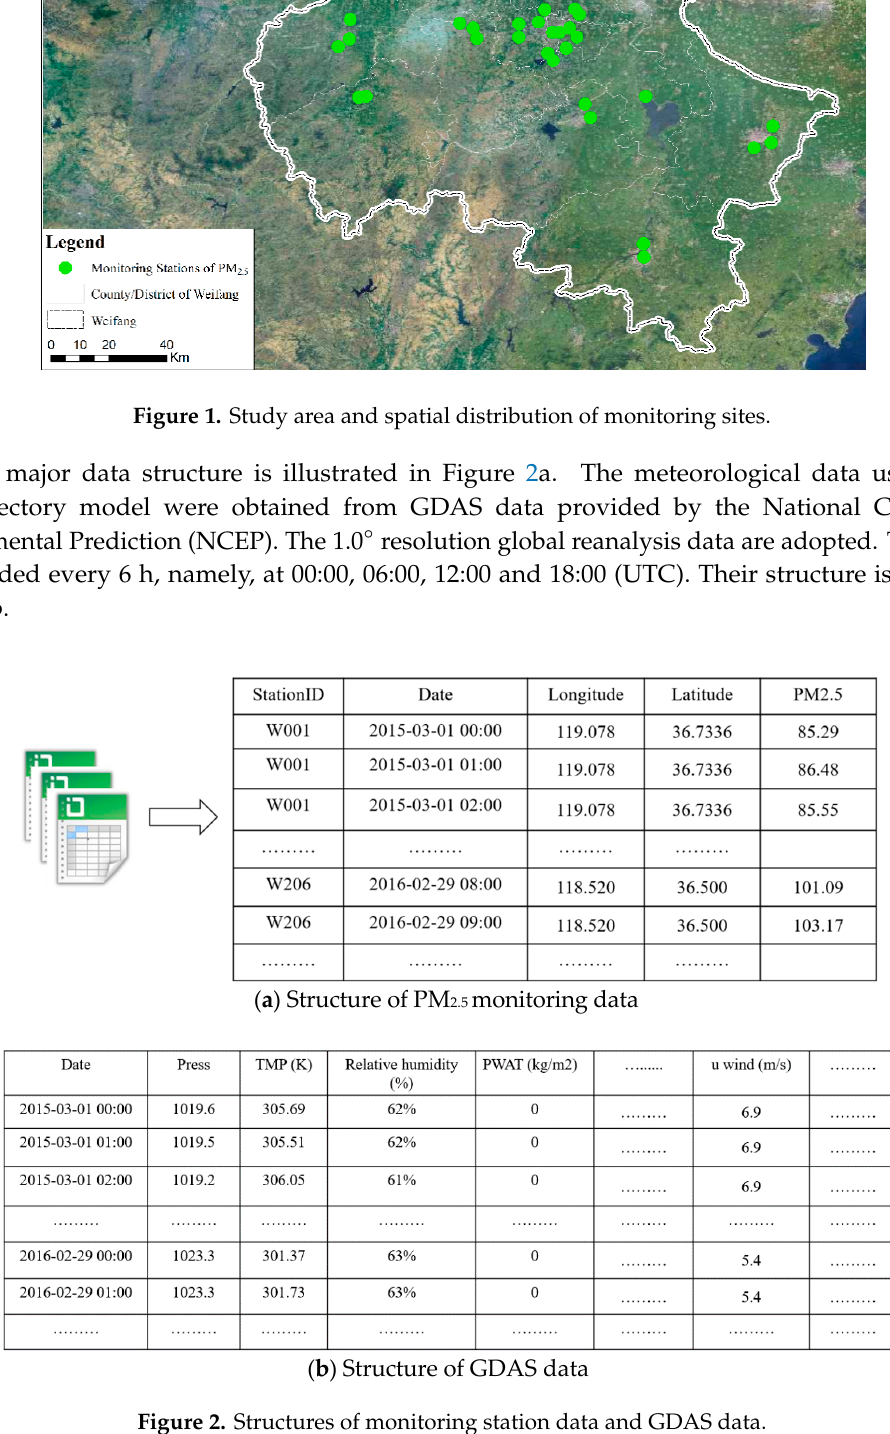
Figure 1. Study area and spatial distribution of monitoring sites.